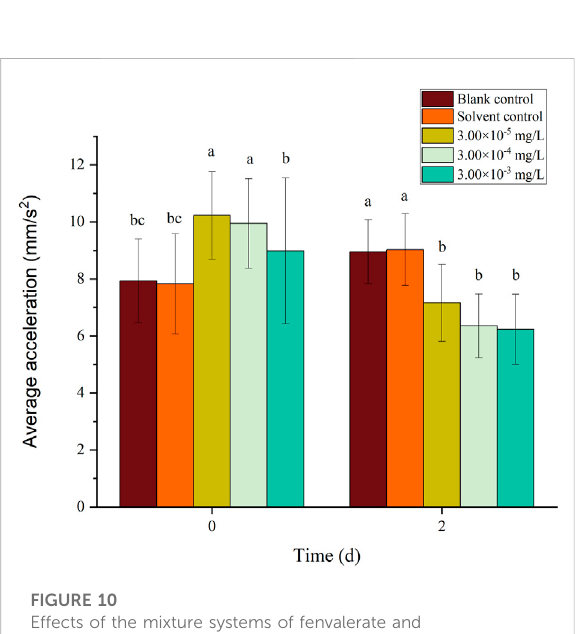
FIGURE 10 Effects of the mixture systems of fenvalerate and tebuconazole on the average acceleration of zebra fi sh larvae